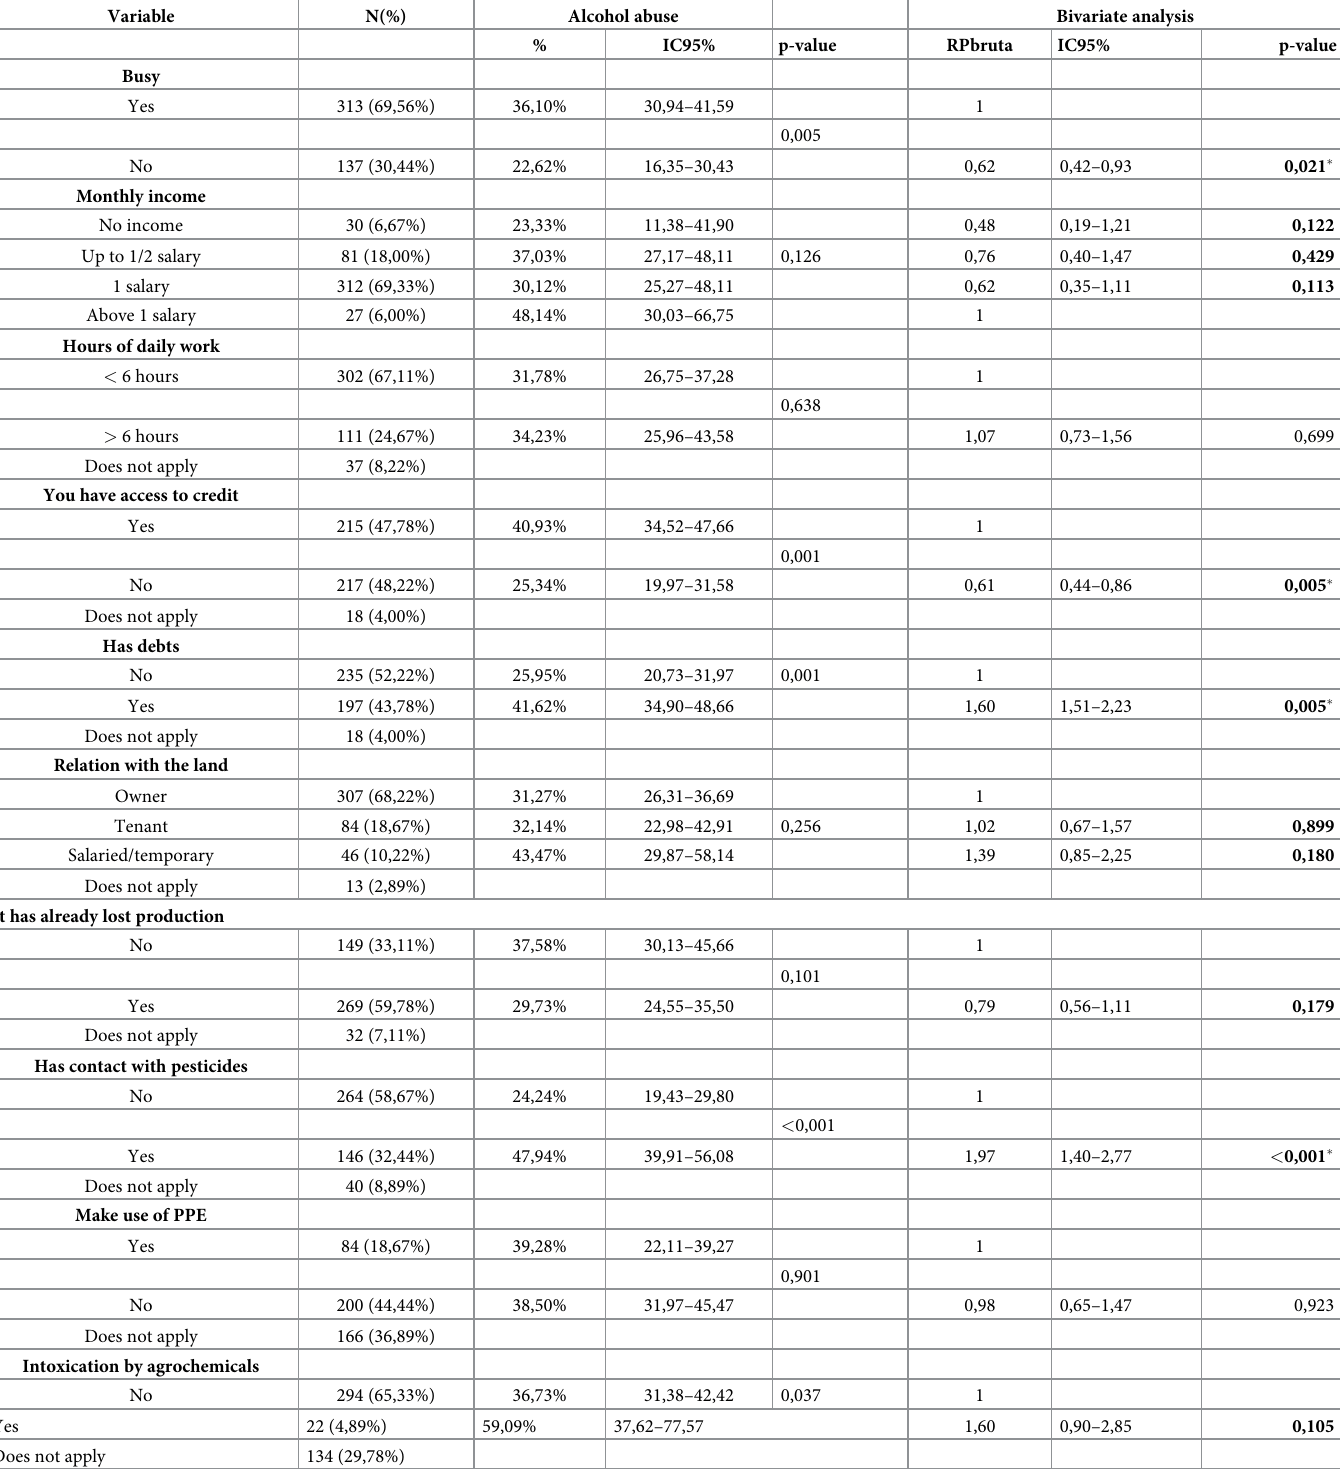
Table 3. Descriptive and bivariate analysis between alcohol abuse and its association with income and labor aspects of farmers in the municipality of Caico´-RN.